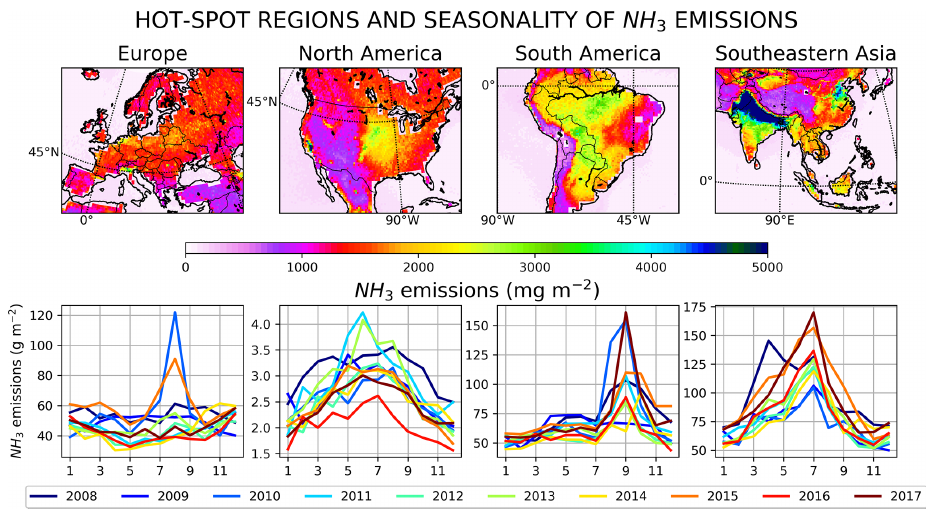
Figure 4. Total annual emissions of ammonia averaged over the 10-year period (2008–2017) in Europe, North America and South America, and Southeastern Asia, which are regions characterized by the largest contribution to the global ammonia budget. In the bottom panels the monthly variation of the emissions is shown for each year of the study